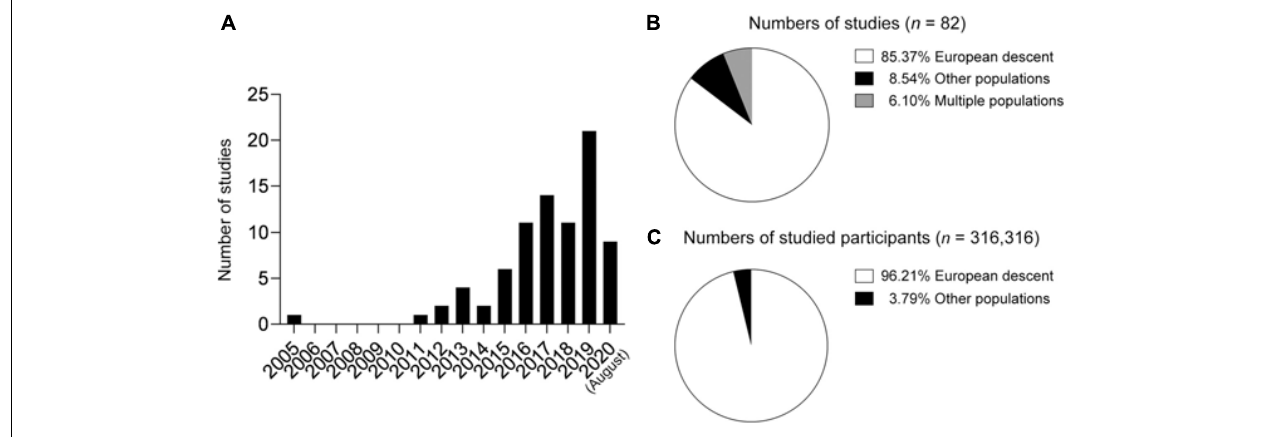
FIGURE 1 | Summary of polygenic score research on Alzheimer’ disease. (A) Numbers of published papers by year. (B) Proportions of studies by population. (C) Proportions of study participants by ethnic